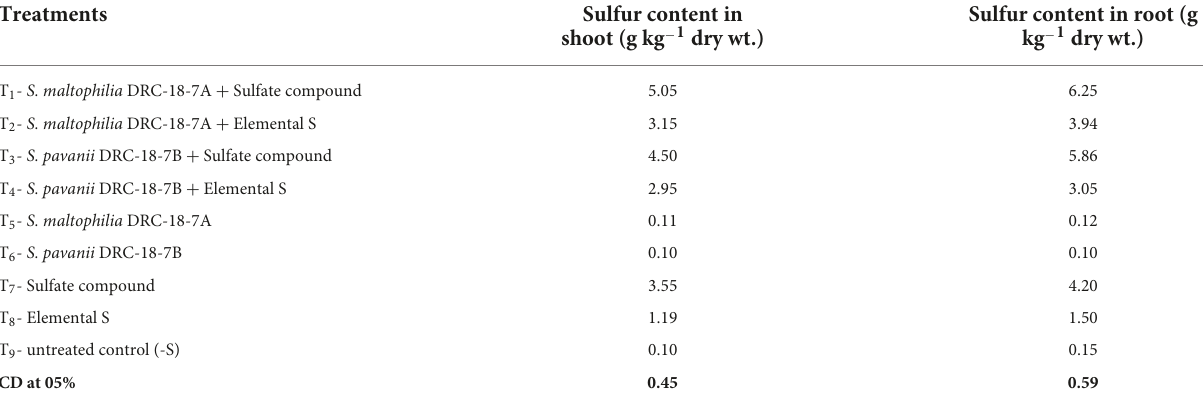
TABLE 4 Effects of inoculation on sulfur content in pigeonpea at 30 days of sowing under glasshouse conditions. Treatments Sulfur content in shoot (g kg − 1 dry